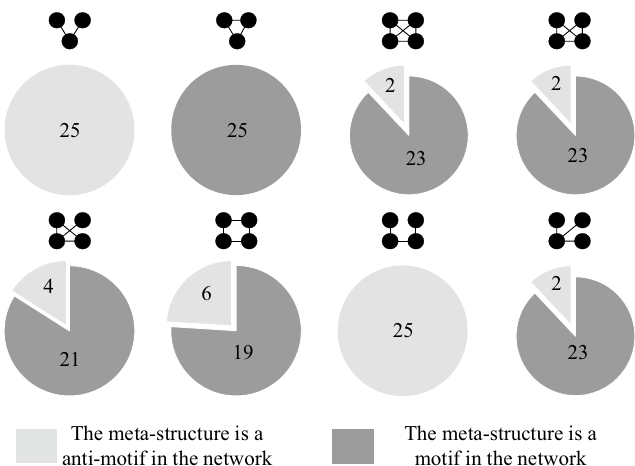
Figure 8. Motifs and anti-motifs of the 25 product structural networks.